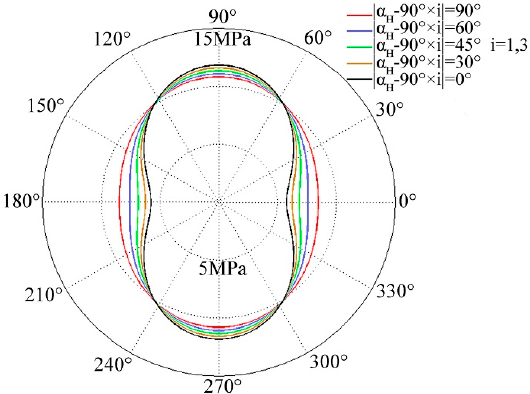
Figure 5. Fracture initiation pressures around the wellbore of the intact rock matrix for different horizontal wellbore drilling directions. The different colors ( red , violet , green , dark yellow and black ) represent different drilling directions ( |𝛼 (cid:3009) − 90° × 𝑖| = 90° , |𝛼 (cid:3009) − 90° × 𝑖| = 60° , |𝛼 (cid:3009) − 90° × 𝑖| = 45° , |𝛼 (cid:3009) − 90° × 𝑖| = 30° and |𝛼 (cid:3009) − 90° × 𝑖| = 0° ), respectively.